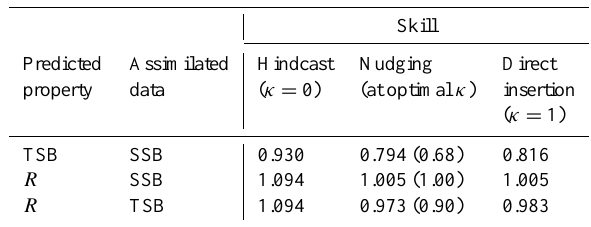
Table 1. SPAM model cost function “cf” (Eq. 10) on total